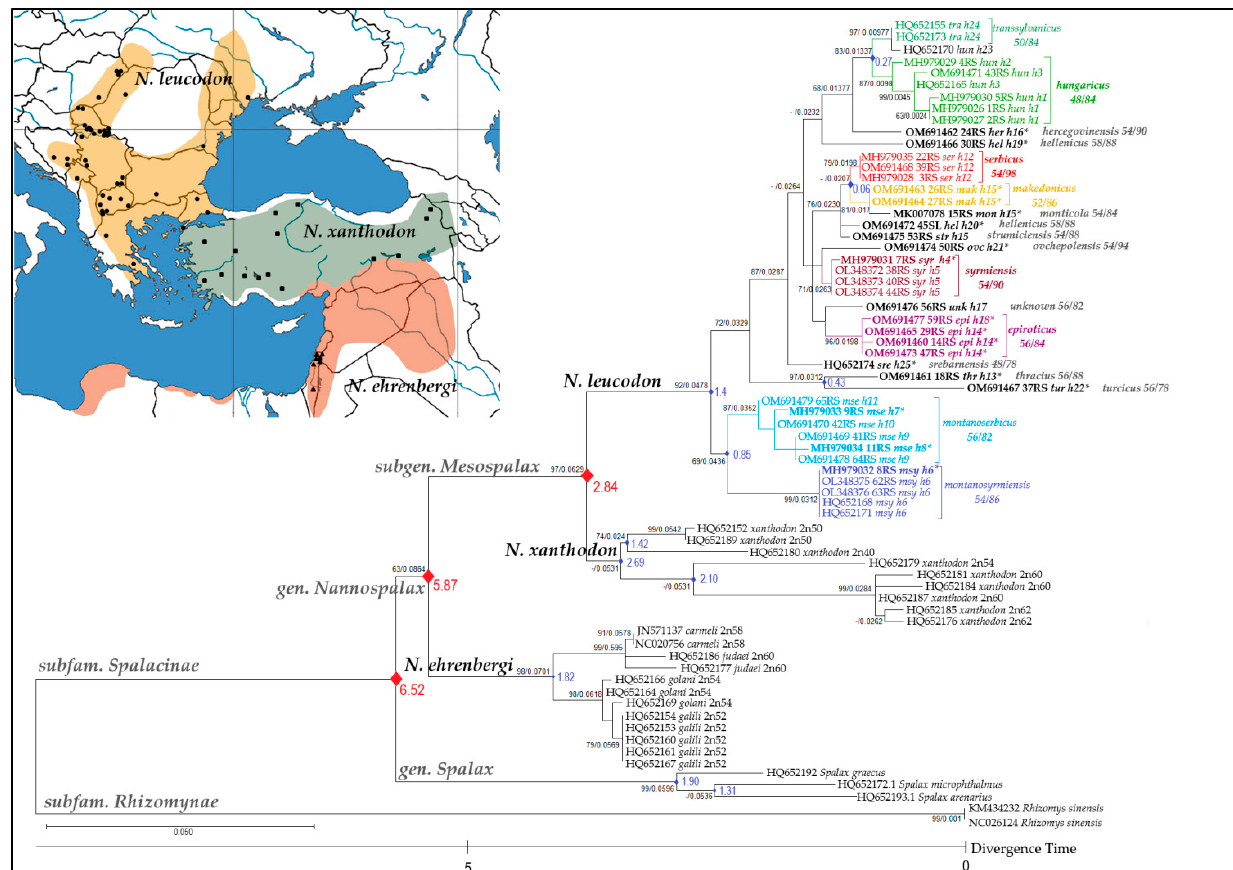
Figure 2. ML phylogenetic tree inferred from 16S rRNA nucleotide comparison. Since both methods (ML and BI) produced highly similar tree topologies, support values are placed at the nodes in that order. The dash indicates branch support < 60. Red dots—calibration constraints used in the timetree analysis; blue dots—estimated divergence time. Sequences in bold with asterisks—karyotyped samples. Geographic map shows the distributional areas of three Nannospalax superspecies with sampling localities of all studied sequences (listed in Tables 1, S1, and S2, and presented in Figure S1). Source of the map: https://d-maps.com/(accessed on 29 March 2022).